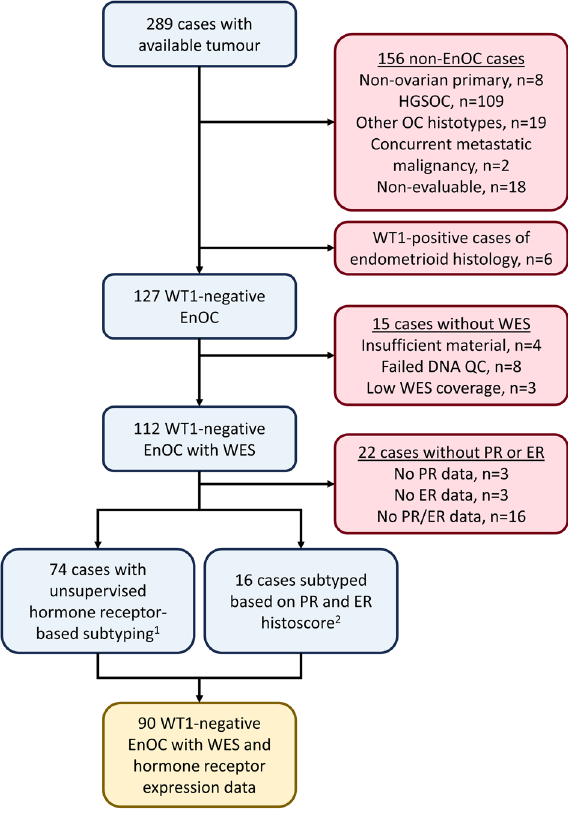
Fig. 1 Case fl ow diagram for endometrioid ovarian carcinoma (EnOC) cases with matched whole exome sequencing (WES) and hormone receptor expression data. 1 74 EnOC cases with unsuper- vised hormone receptor subgroup available from the previous study 24 . 2 16 EnOC cases identi fi ed subsequent to the unsupervised subgrouping study of hormone receptor expression patterns with available WES 23 ; these cases were classi fi ed by available oestrogen and progesterone receptor (ER and PR) immunohistochemistry data, using a histoscore threshold of ≥ 150. HGS, high grade serous; WT1, Wilms ’ tumour 1; QC, quality control; PR, progesterone receptor; ER, oestrogen (Supplementary Fig. 1). The median MATH scores for the PR + /ER + , PR + /ER − , PR − /ER + and PR − /ER − subtypes were 29.7, 30.2, 40.8 and 38.8, respectively. The HREP-based subtypes also demonstrated signi fi cantly different CNA burden (Fig. 2b); PR-low cases displayed more frequent CNA events compared to PR-high cases (median 37 vs 11, P = 0.001). PR − /ER − and PR + /ER + cases demonstrated the greatest and smallest CNA burden, respectively (median 41.5 vs 6 CNA events, P < 0.001). There was no signi fi cant difference in overall CNA burden between the two PR-high (PR + /ER + vs PR + /ER − , P = 0.370) or PR-low subtypes (PR − /ER − vs PR − /ER + , P = 0.101). A markedly higher frequency of copy number gain events was noted in the PR − /ER − group speci fi cally (median 25 vs 2, 2.5 and 4 in the PR + /ER + , PR + /ER − and PR − /ER + groups) (Supplementary Figure 2). PR − /ER − cases demonstrated frequent loss of LNX1 and SNORA80A , and gain of ZNF4 , STK24 and CCDC191 ; gain of CDK20 was common in PR-high tumours (Supplementary Tables 1 and 2). There was no signi fi cant difference in tumour mutational burden (TMB) between the HREP-based subtypes ( P > 0.2) (Fig. 2c); median TMB for the PR + /ER + , PR + /ER-, PR − /ER + and PR − /ER − groups was 80, 72.5, 74 and 79, respectively. The PR-/ER- group demonstrated the highest frequency of mutation in